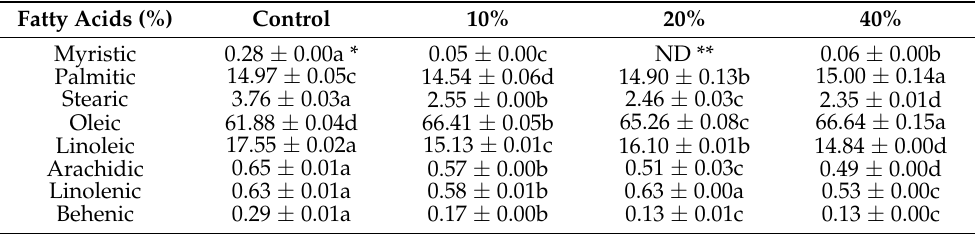
Table 3. Fatty acid compositions of the oils extracted from bread samples enriched with chufa flour at different concentrations. Fatty Acids (%)